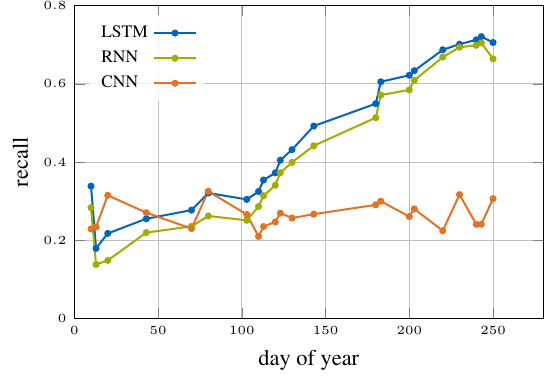
Figure 10. Evolution of performance of LSTM, RNN, and CNN networks with increasing number of observations. The more observations have been registered, the more context information was available to multi-temporal LSTM and RNN networks to assist the classification decision. CNN models can not utilize temporal information, thus performance remained at a nearly constant level with increasing observation length.